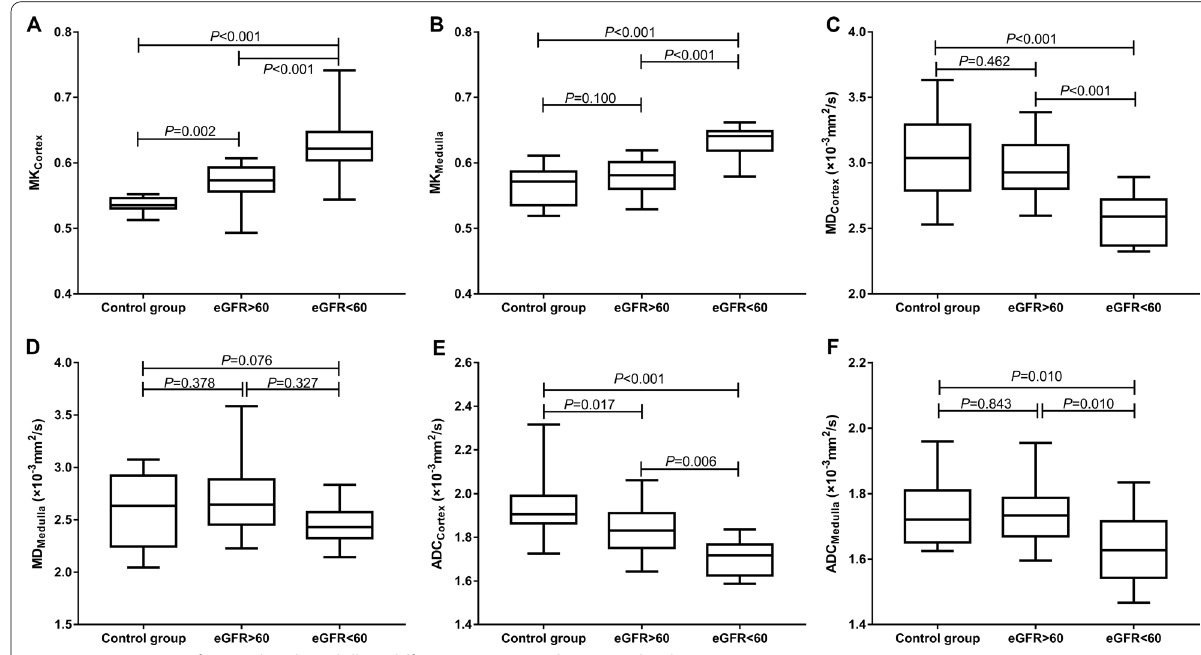
Fig. 5 Comparison of cortical and medullary diffusion parameters between the three groups